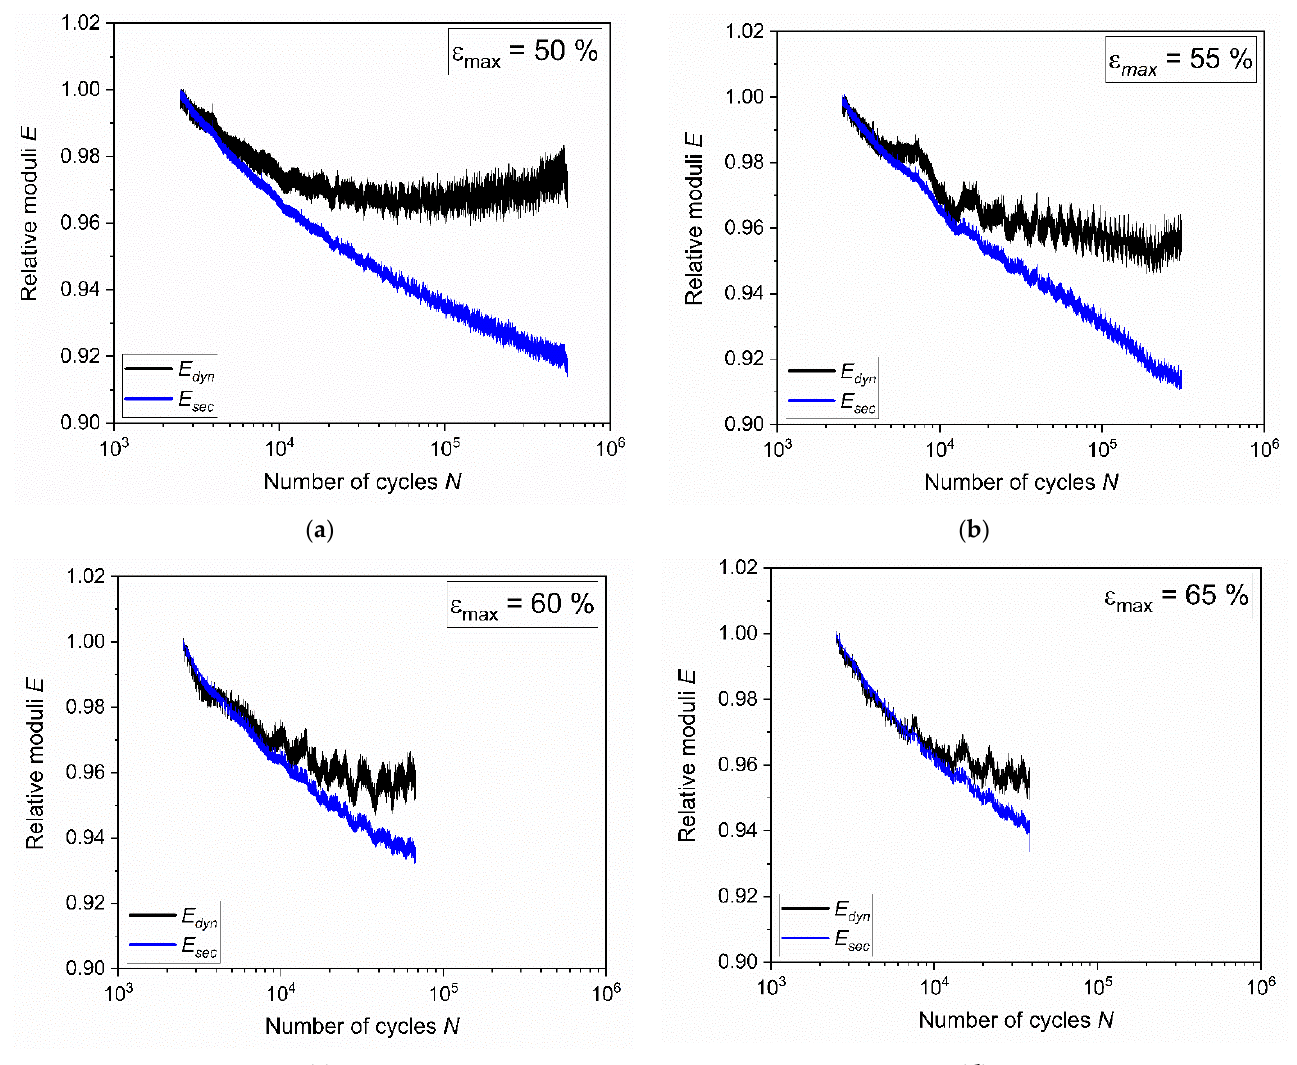
Figure 6. Dynamic ( E dyn ) and secant ( E sec ) moduli evaluated from hysteresis at maximum strain of ( a ) 50%, ( b ) 55%, ( c ) 60%, and ( d ) 65%, respectively. The fatigue tests were implemented on axisymmetric dumbbell specimens of CB filled NBR at a frequency of 4 Hz and a load ratio R ε of 0.5. Subsequently, the energies were analyzed by integrating the area of the force-displacement curves from the hysteresis curves previously discussed. In this sense, it was possible to distinguish between the dissipated energy, U dis , as the area inside the hysteresis loop, and the stored energy, U sto , as the area below the unloading curve. For a proper comparison, the evolution of the energies was plotted as a function of the normalized number of cycles (currently elapsed number of cycles, N, divided by the number of cycles to failure, N f ) as reported in Figure 7a. These results originate from the behavior already described for the hysteresis curves: in all the testing configurations, a drop in both energies was observed during the first cycles. As previously discussed, this effect is mainly a consequence of stress relaxation. After the drop, the values of U dis are then substantially stabilized for plateau values. The stored energy U sto instead kept decreasing with the number of cycles, albeit slightly, due to energy dissipation caused by material damage. On the other hand, the dissipated energies moderately increased, evidencing the increase in damage in the material. Moreover, a clear trend with respect to the maximum strains is present: both dissipated and stored energies were higher for higher strains; however, this